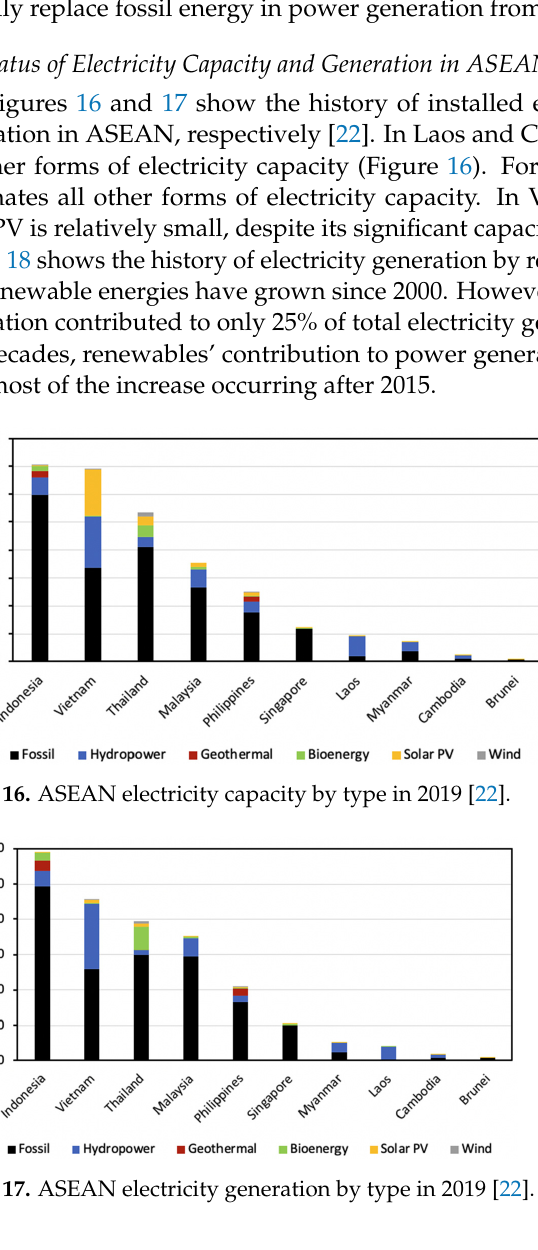
Figure 18. History of fossil and renewability electricity generation in ASEAN [22] . 4.2. Status of Energy Consumption in ASEAN Figure 19 shows the history of renewable energy consumption as a percent of total final energy consumption (TFEC) [44]. TFEC includes contributions from all energy-con- sumption sectors. All ASEAN countries, except Thailand and Malaysia, show a decreasing